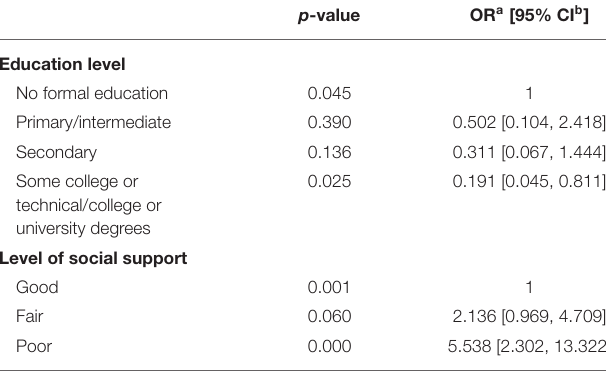
TABLE 5 | Multiple linear regression analysis of ISMI scores. TABLE 6 | Multiple logistic regression analysis of ISMI